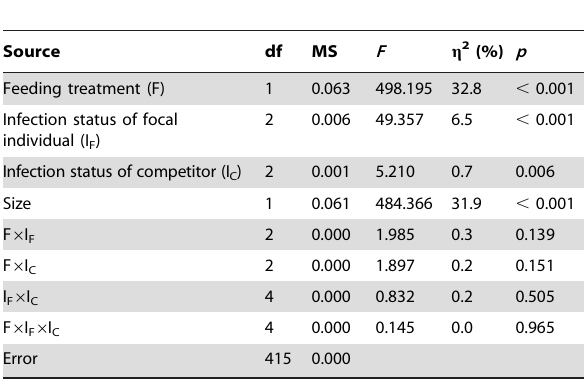
Table 1. ANCOVA for the specific growth rate of Lymnaea stagnalis snails during the